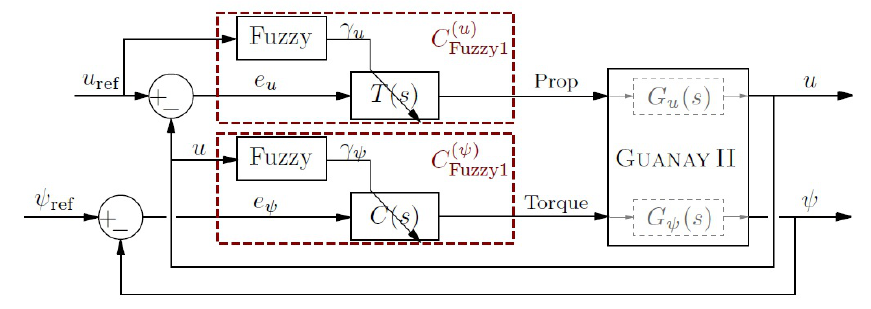
Figure 13. Fuzzy control: velocity and yaw control regarding the forward velocity u